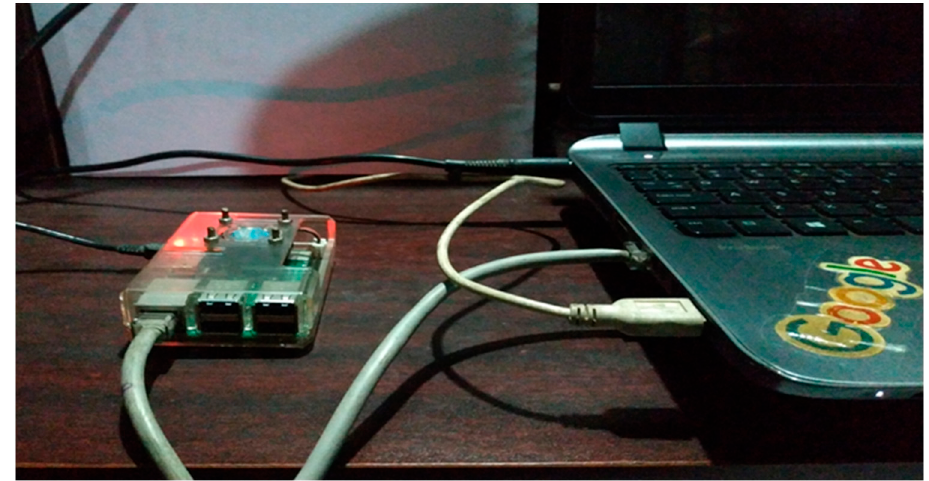
Figure 8 . LIS to RSPI3 connection